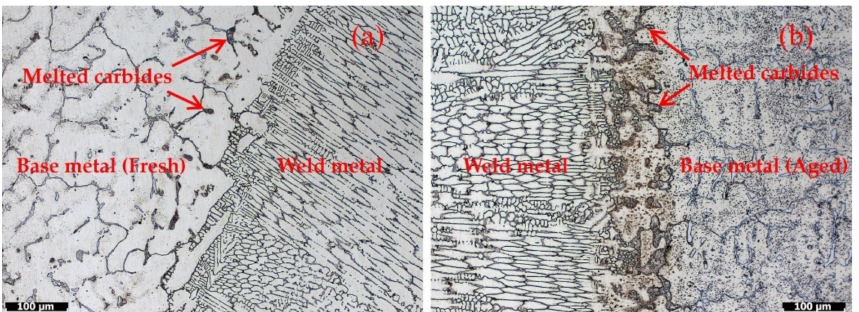
Figure 7. Optical microscopy images of the fresh-to-aged welded joint: ( a ) fresh alloy/weld metal and ( b ) aged alloy/weld